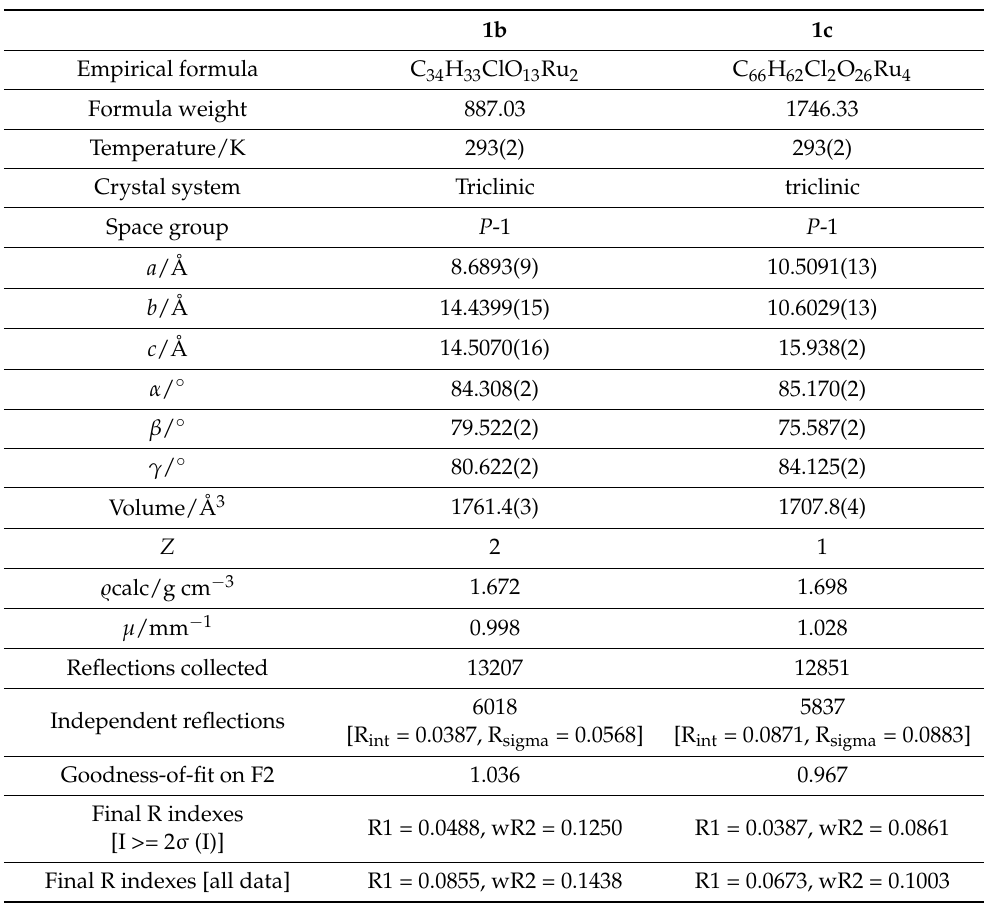
Table 1. Crystal and refinement for 1b and 1c